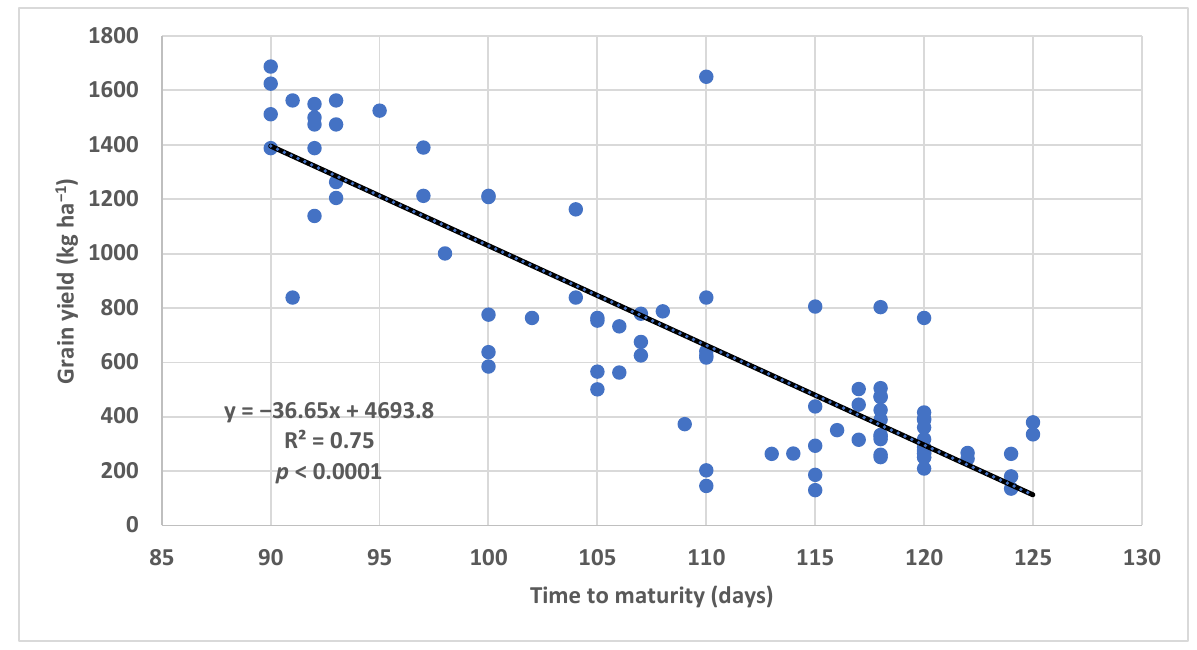
Figure 3. Linear regression of the yields of 22 sorghum varieties and time to maturity (2014/2015 season Yélimané).